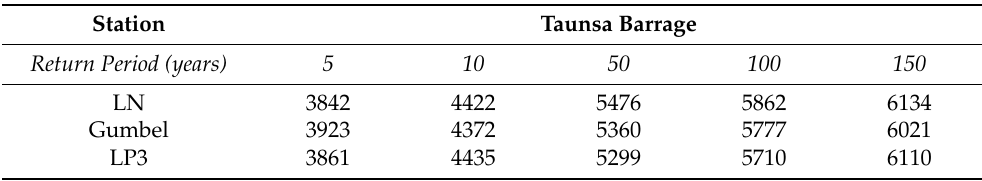
Table 4. Maximum instantaneous discharge (m 3 s − 1 ) according to the LN, Gumbel, and LP3 probabil- ity distributions at Taunsa Barrage for floods of various return